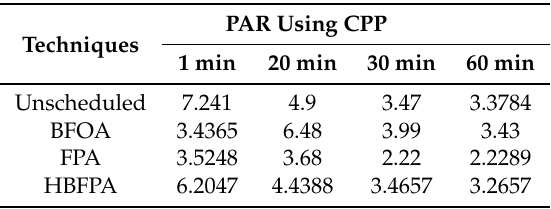
Table 7. Peak to average ratio for 24 h (for single